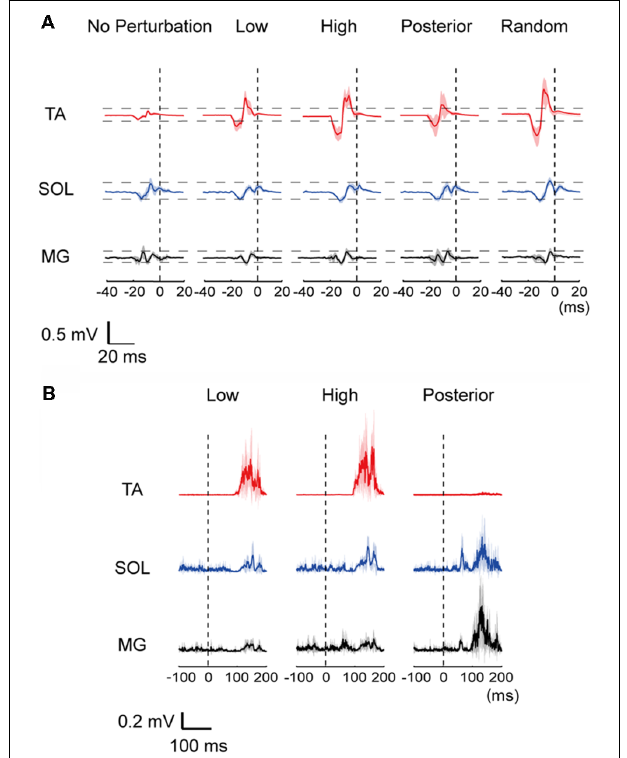
FIGURE 2 | (A) Representative row motor-evoked potentials (MEPs) imposed for all trials for one subject. The MEPs in the three muscles are depicted at the same scale. “0”: the time point of perturbation onset. TA, tibialis anterior; SOL, soleus; MG, medial gastrocnemius. (B) Muscle activities of the TA, SOL and MG following a perturbation in a representative data. A mean (thick line) and standard error (SE; shaded) activities in each muscle were depicted. “0 ms” corresponds to the beginning of the floor